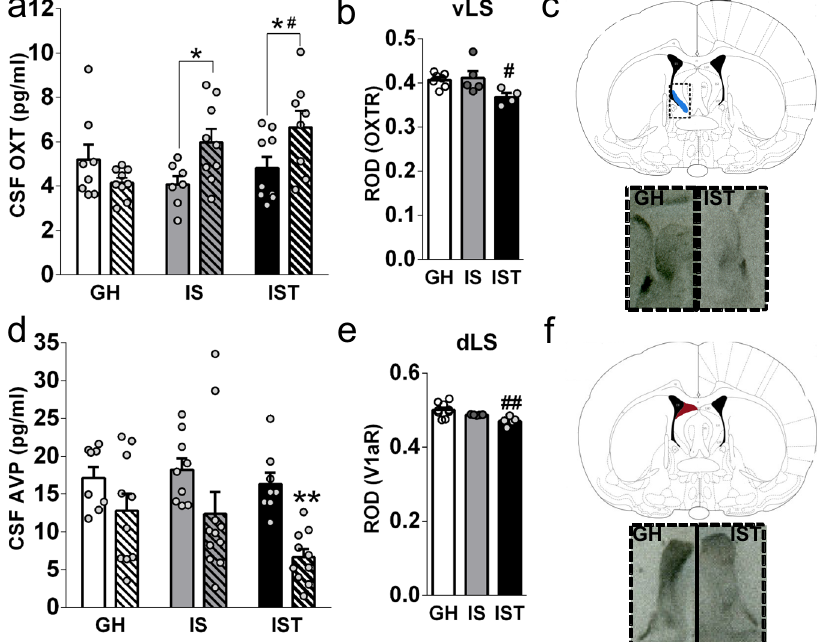
Fig. 2 The high levels of aggression displayed by isolated and trained (IST) rats are accompanied by high OXT and low AVP concentrations in cerebrospinal fl uid (CSF), and low OXT and V1a receptor binding in the lateral septum (LS). a IS and IST females showed higher concentrations of OXT in CSF immediately after exposure to the female intruder test (FIT) compared with respective control rats (CTRL) (two-way ANOVA followed by Bonferroni: factor FIT: F (1,44) = 3.91, p = 0.054; housing: F (2,44) = 1.96, p = 0.152; FIT × housing: F (2,44) = 4.68, p = 0.014). b IST females presented decreased OXT receptor (OXTR) binding, displayed as relative optical density (ROD), in the ventral portion of the LS (vLS) (Kruskal – Wallis test followed by Dunn ’ s: H (3) = 7.12, p = 0.02. c Scheme illustrating localization of OXTR in the vLS, and magni fi cation of representative example autoradiograph (left: GH; right: IST). d FIT exposure decreased CSF AVP levels only in IST rats (two-way ANOVA, factor FIT: F (1,50) = 15.98, p = 0.0002; housing: F (2,50) = 2.13, p = 0.129; FIT × housing: F (2,50) = 0.90, p = 0.41). e IST females presented decreased V1aR binding, shown as ROD, in the dorsal part of the LS (dLS) (H (3) = 8.72, p = 0.006). f Scheme illustrating localization of V1aR in the dLS and magni fi cation of representative autoradiograph (left: GH, right: IST). All data are presented as mean + SEM. # p < 0.05, ## p < 0.01 vs GH; * p < 0.05, ** p < 0.01 vs control. Binding: GH : n = 8; IS: n = 4; IST: n = 5; OXT: GH: n = 17; IS: n =